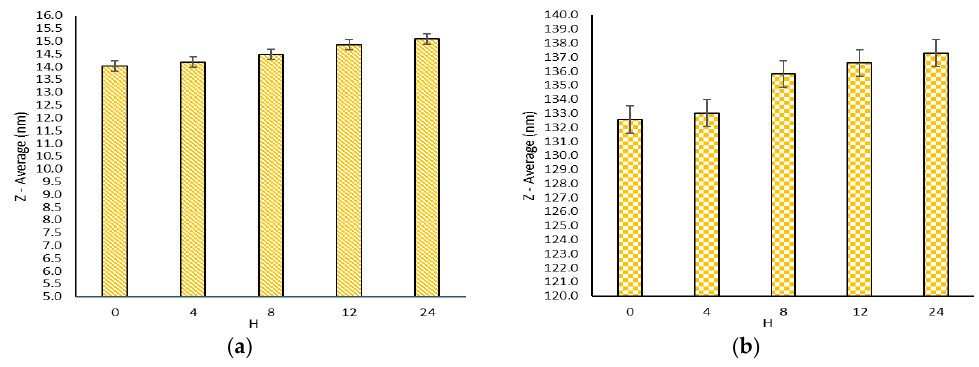
Figure 2. Particle size changes in formulation I ( a ) and formulation III ( b ) at room temperature (condition A).